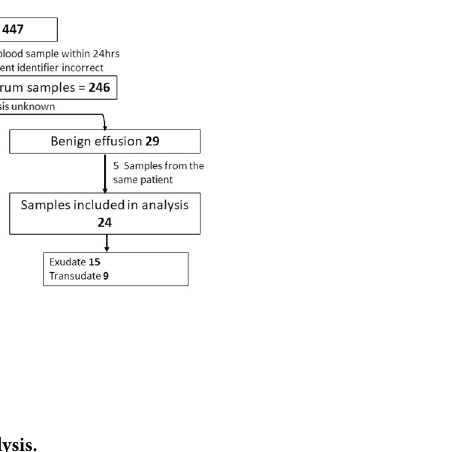
Table 1. MM patients had a better prognosis from the time of MPE sample collection than patients with other cancer types (HR = 0.55, 0.36–0.84; p = 0.006). Neutrophil and lymphocyte percentages differ between pleural fluid and